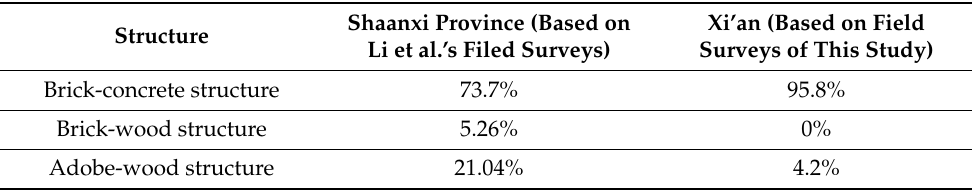
Table 1. Distribution of different house structures in the villages.